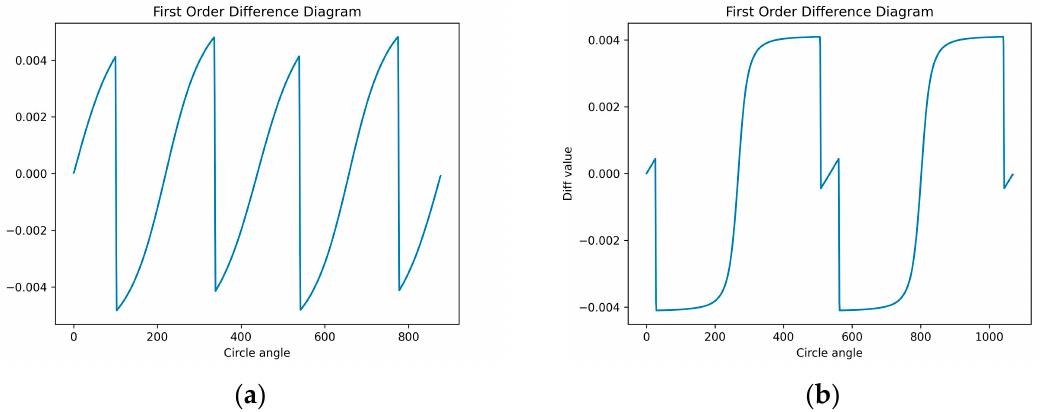
Figure 14. First-order difference diagram of blocky particles and strip particles: ( a ) Difference diagram of blocky particles; ( b ) Difference diagram of strip particles.